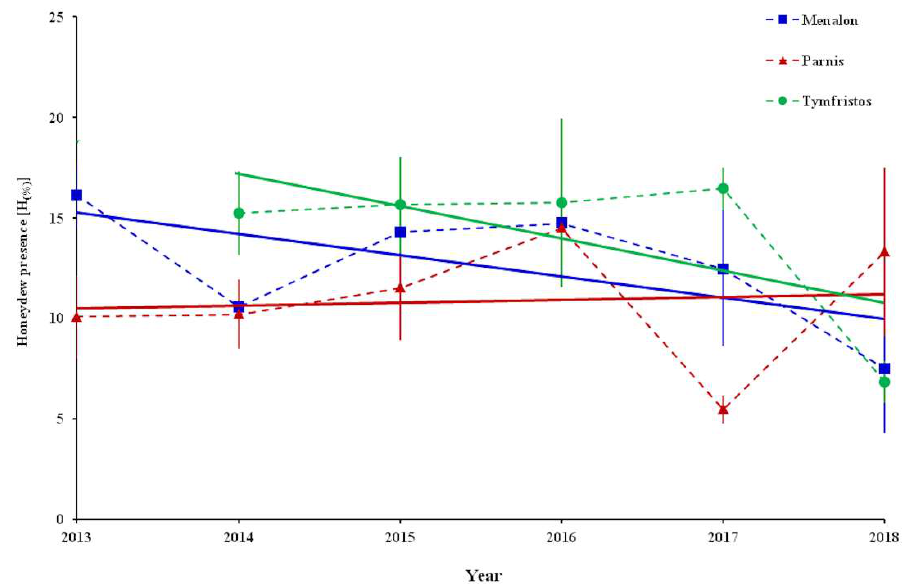
Figure 7. Percentage of honeydew presence [H (%) ] of P. hellenicus female individuals during the sampling period 2013–2018 at Menalon and Parnis and 2014–2018 at Tymfristos. Red, blue and green lines indicate the trends of mean values of Menalon, Parnis and Tymfristos, respectively.